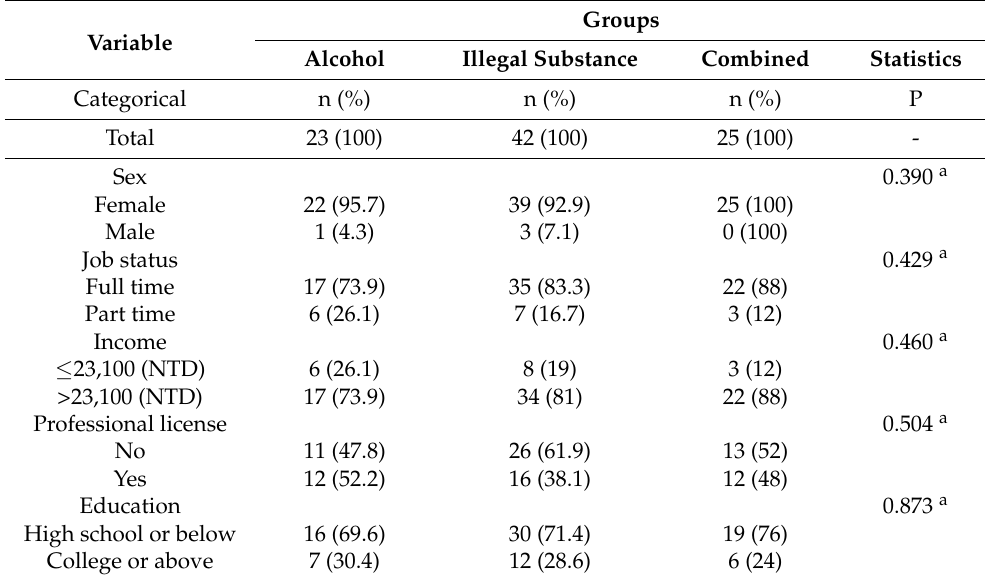
Table 1. Sociodemographic characteristics of participants (n =